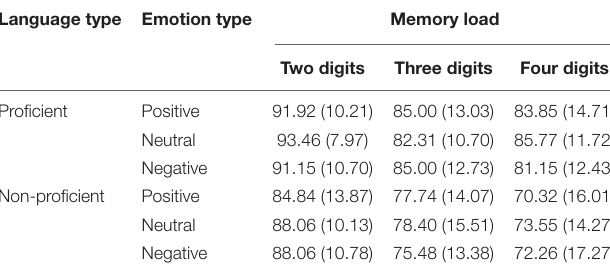
TABLE 2 | Mean score and standard deviation for accuracy on E-DMTS task by different language groups [M